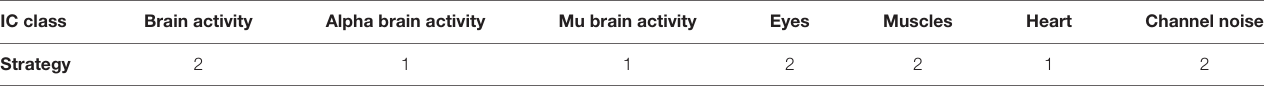
TABLE 1 | IC classes and corresponding aggregation strategies based on the total number of positive samples of each class.